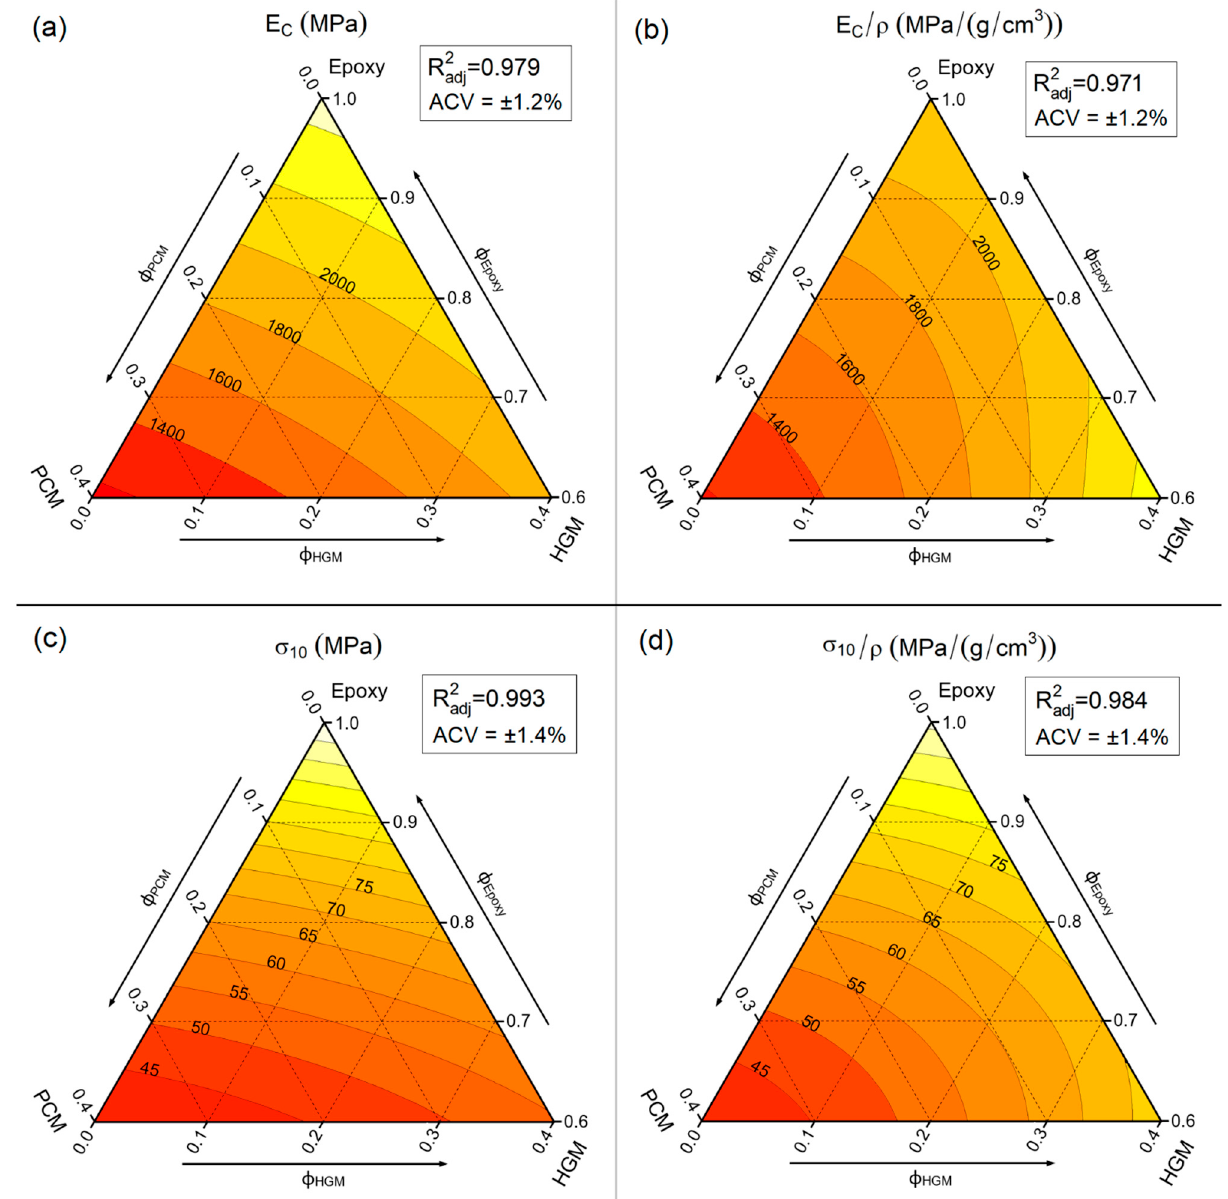
Figure 5. Fit-models of the main results of quasi-static compressive tests on the prepared syntactic foams. ( a ) compressive modulus (E c ); ( b ) specific compressive modulus (E c / ρ ); ( c ) compressive stress at a strain of 10% ( σ 10 ); and ( d ) specific compressive stress at a strain of 10% ( σ 10 / ρ ). ACV average coefficient of variance. R 2 adj = adjusted R-squared, ACV = average coefficient of variance.